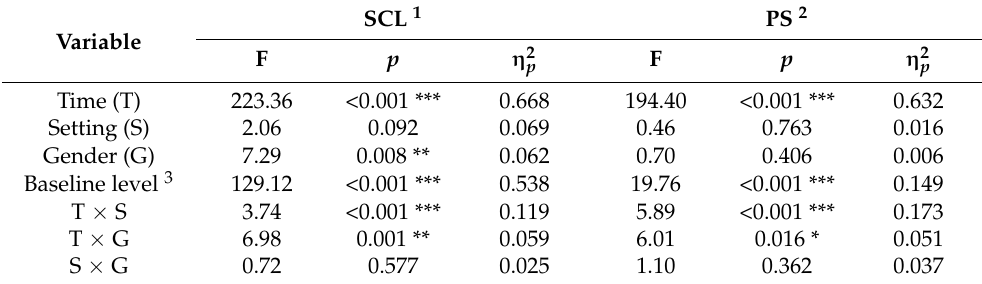
Table 3. Results of RM-ANOVA for skin conductance level (SCL) and perceived stress